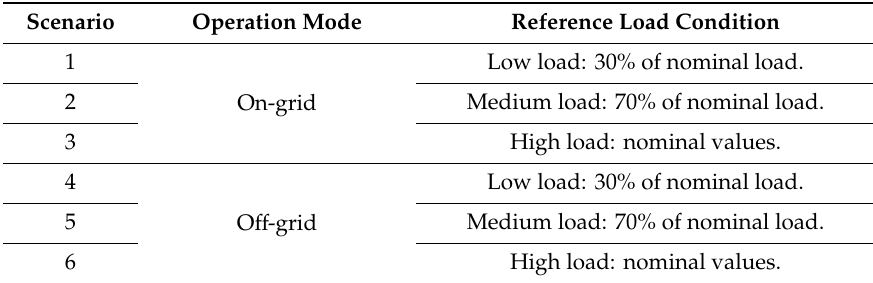
Table 5. Operational condition of microgrid.